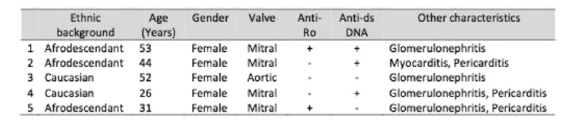
Table 1 (abstract P083). MAIN CHARCATERISTICS OF 5 SYSTEMIC LUPUS ERYTHEMATOSUS PATIENTS SUBMITTED TO CARDIAC VALVE